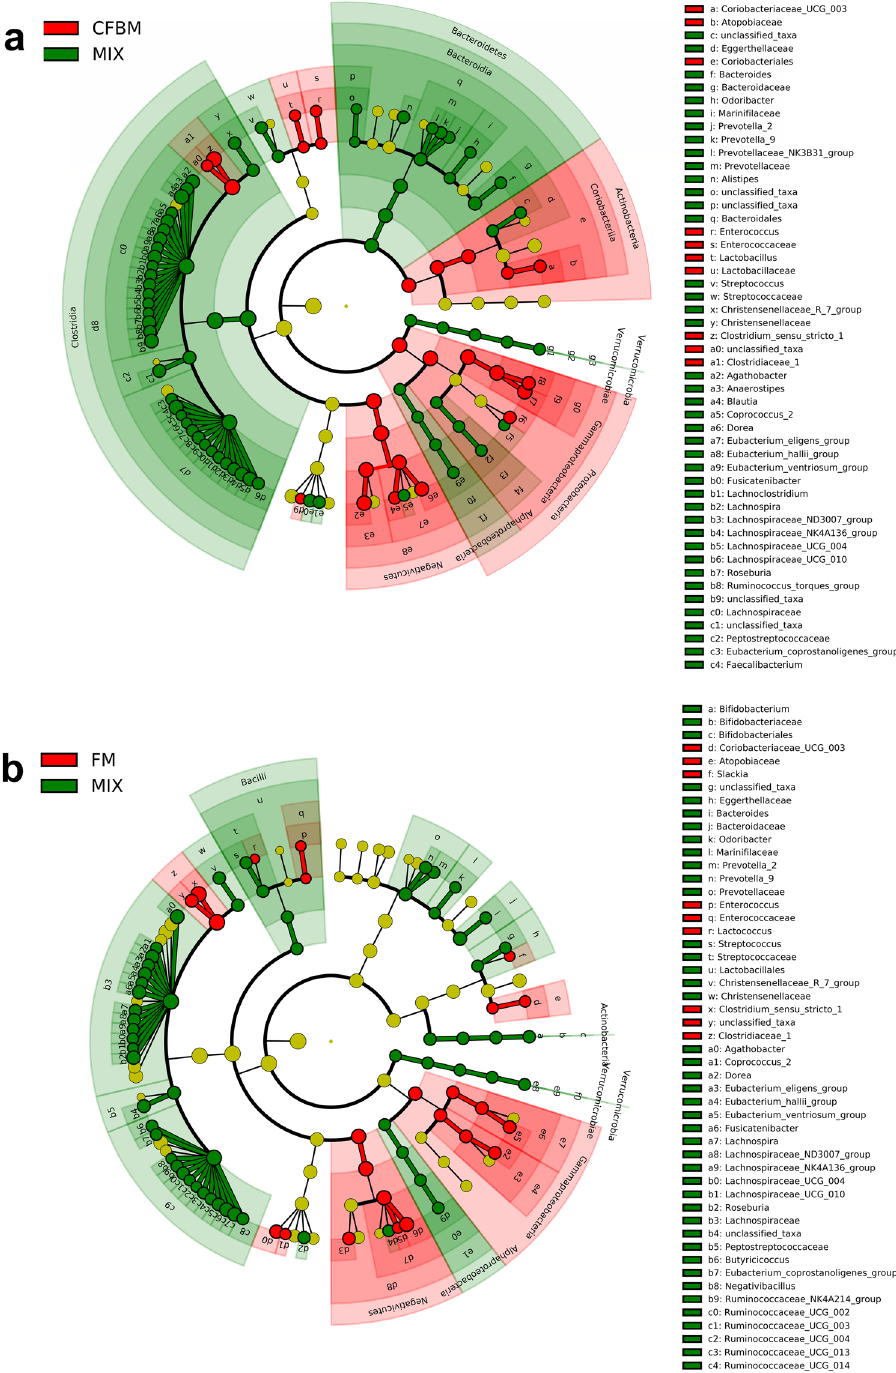
Figure 4. Linear discriminant analysis Effect Size (LEfSe) cladogram of the GM composition after 24 h of cultivation in four different media: CFBM ( a ), FM ( b ), GMM ( c ), and SM ( d ) compared to the non-cultured MIX inoculum (n = 6). Red, green, and nodes/shades indicate taxa that are significantly higher in relative abundance in each group; the diameter of each node is proportional to the taxon’s abundance; each successive circle represents a phylogenetic level. LDA score > 2, p < 0.05. Samples represent viable bacteria after PMA